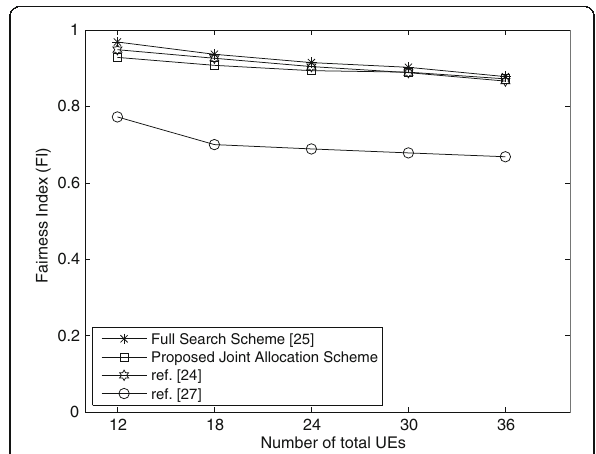
Fig. 9 Comparison of the fairness index, in respect to Fig.